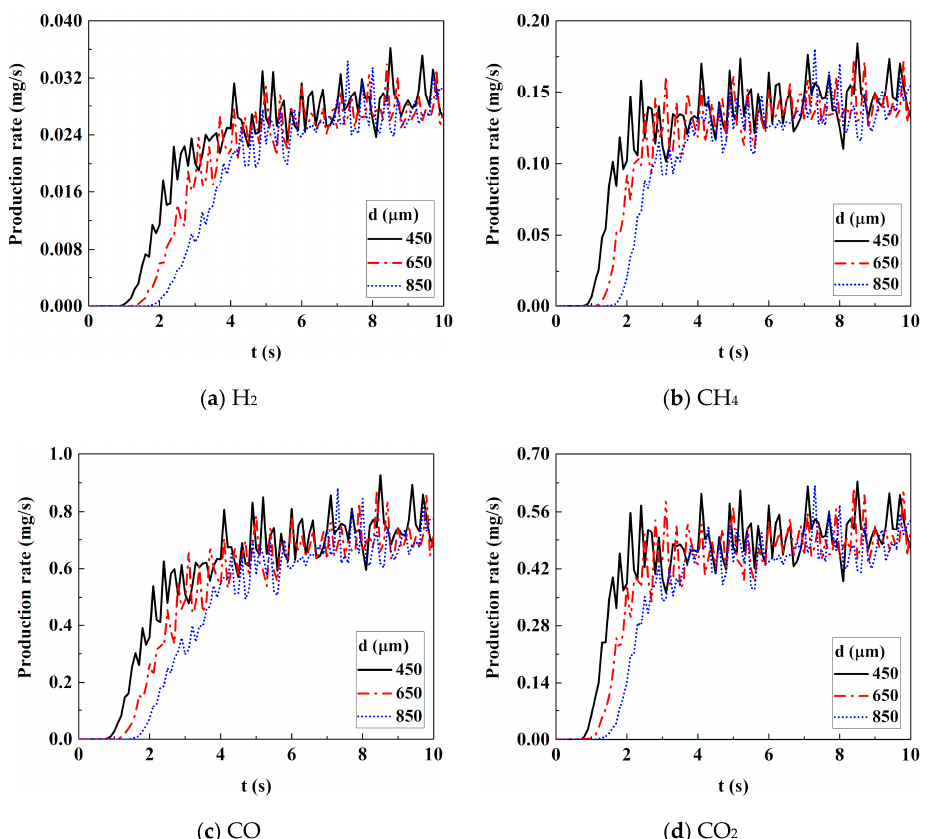
Figure 13. Light gas production rate for different particle sizes.